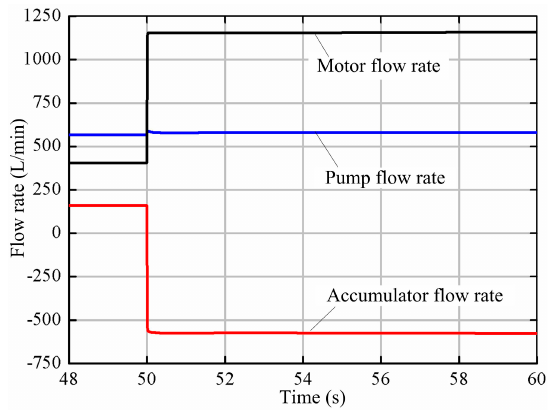
Figure 18. Pump, accumulator, and motor flow rate.